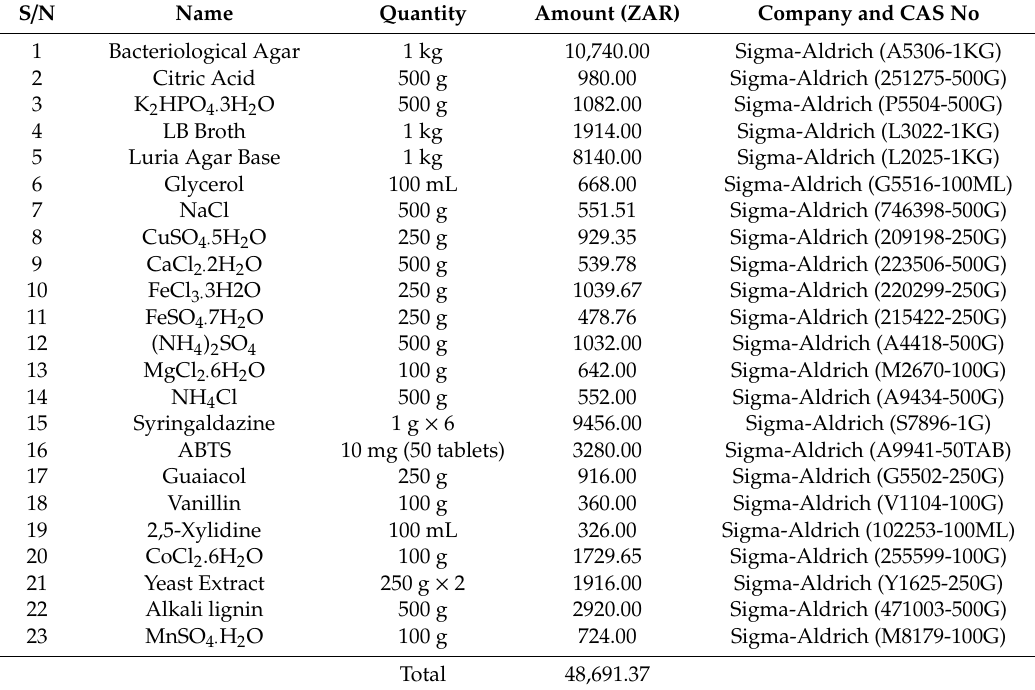
Table 4. Cost of selected chemicals for production of inoculum and microbial